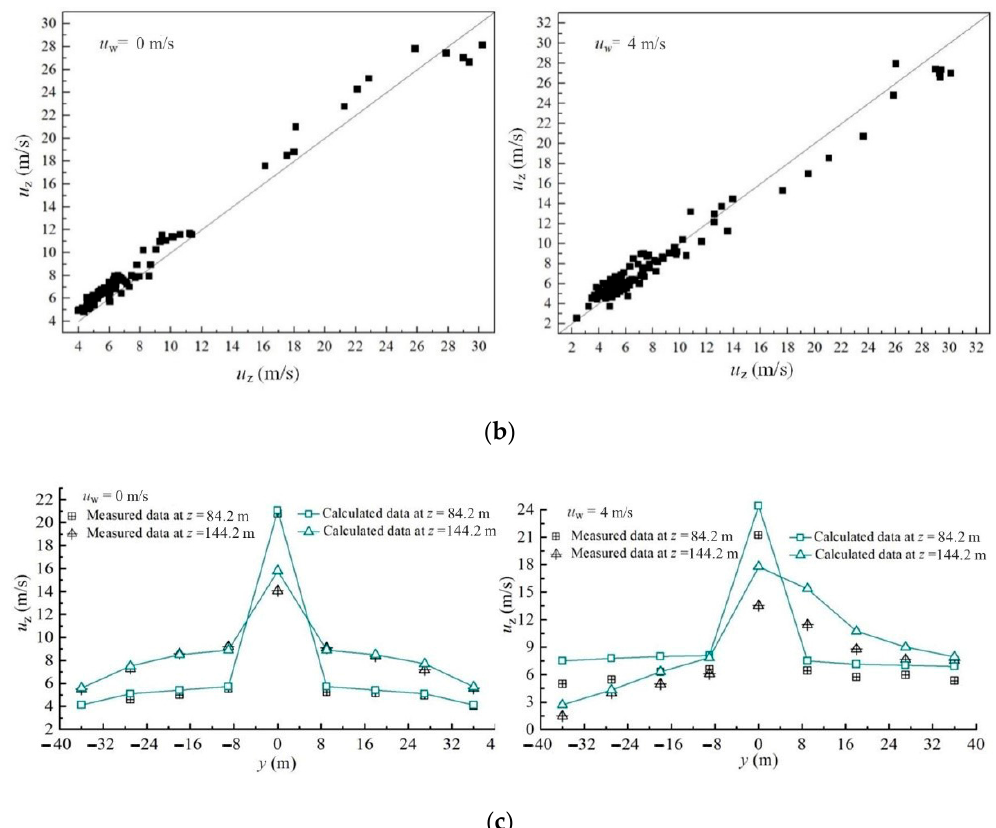
Figure 5. Experimental procedure of NDDCS and comparison with numerical simulation [3,30,45]. ( a ) Measuring points; ( b ) ascending air velocities of all measuring points in the absence of wind and under a crosswind of 4 m/s; ( c ) ascending air velocities at two typical heights in the absence of wind and under a crosswind of 4 m/s.